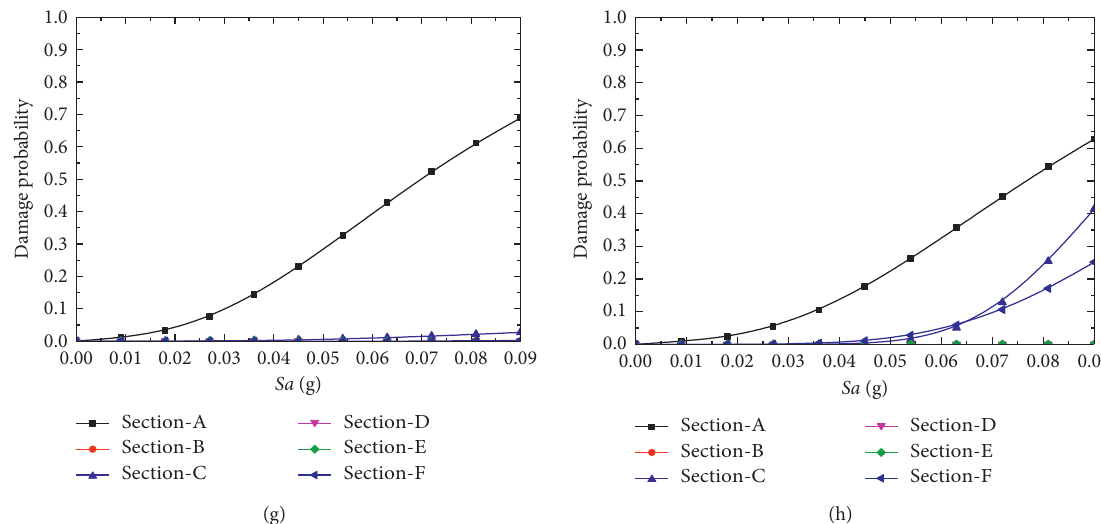
Figure 6: The fragility curves of the Puli Bridge. (a) Slight damage fragility curves of the key section of the left leg. (b) Slight damage fragility curves of the key section of the right leg. (c) Mid damage fragility curves of the key section of left leg. (d) Mid damage fragility curves of the key section of the right leg. (e) Severe damage fragility curves of the key section of the left leg. (f) Severe damage fragility curves of the key section of the right leg. (g) Complete damage fragility curves of the key section of the left leg. (h) Complete damage fragility curves of the key section of the right